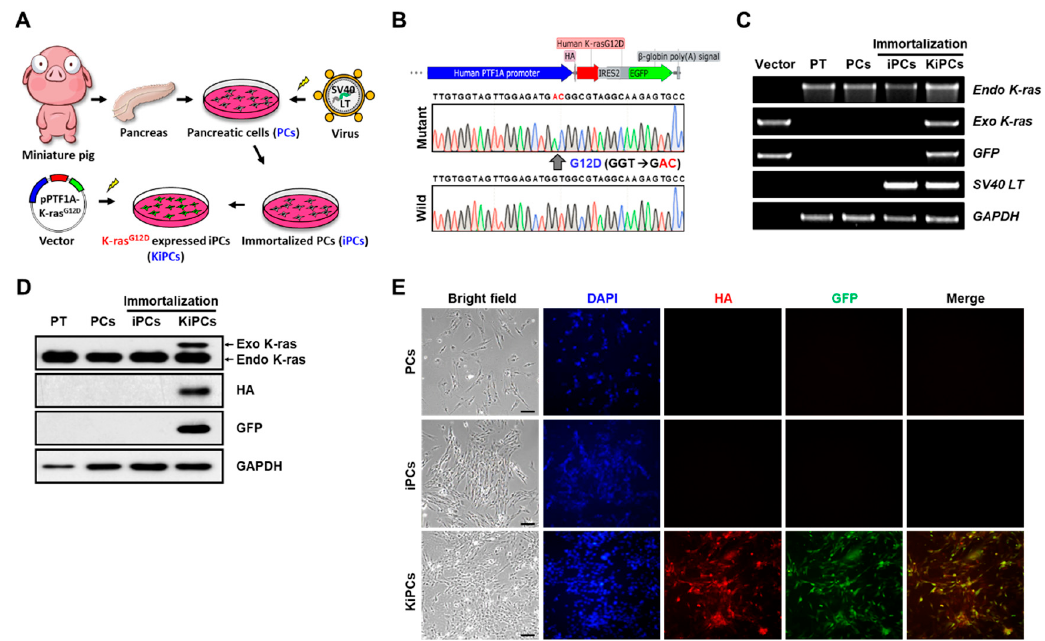
Figure 1. Verification of K-ras G12D expression under the control of the human PTF1A promoter in